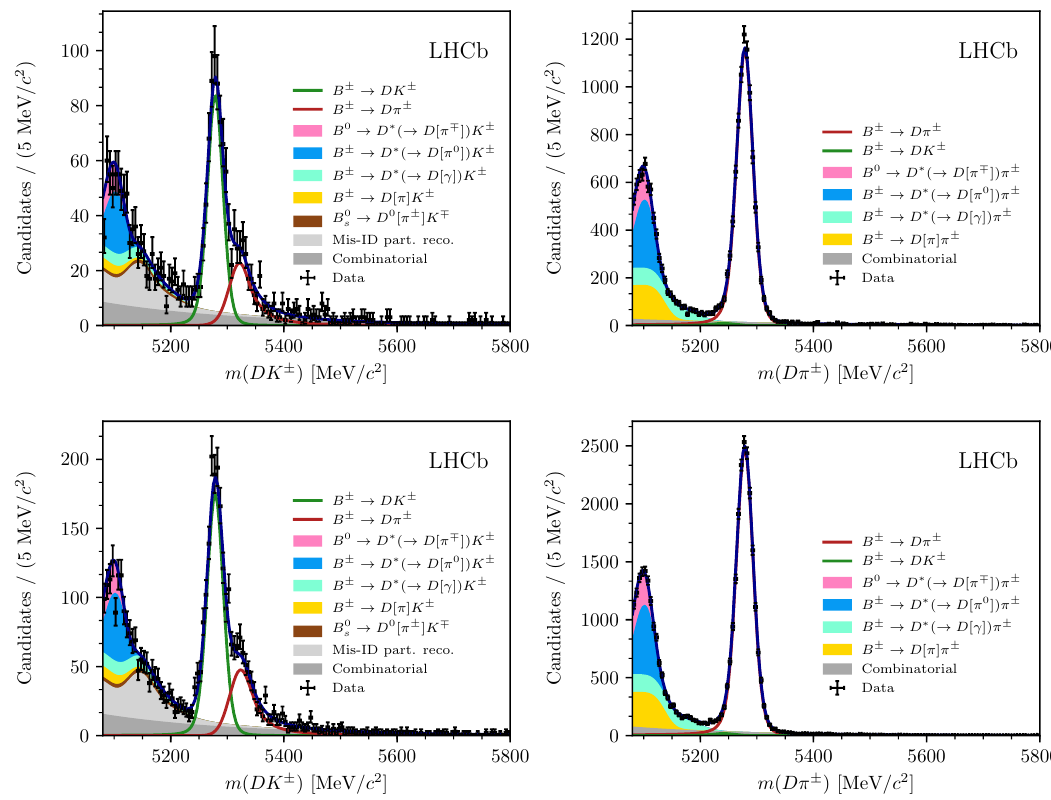
Figure 4 . Invariant mass distributions for the (left) B ± → DK ± channel and (right) B ± → Dπ ± channel with D → K 0 K + K − . The top (bottom) plots show data where the K 0 S ( downstream ). Square brackets in the legend denote a particle that has not been